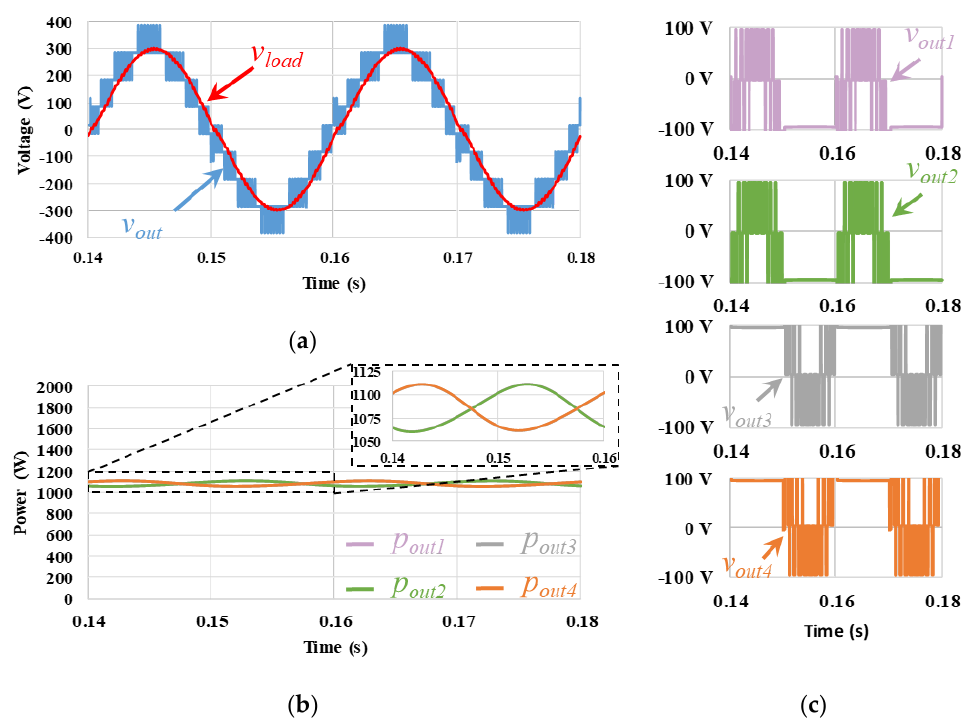
Figure 23. Simulation results of the PSD PWM technique: ( a ) output voltage of the cascaded MLC, v out , and load voltage, v load ; ( b ) output power on each submodule ( p out1 , p out2 , p out3 , p out4 ); ( c ) output voltage on each submodule ( v out1 , v out2 , v out3 , v out4 ).